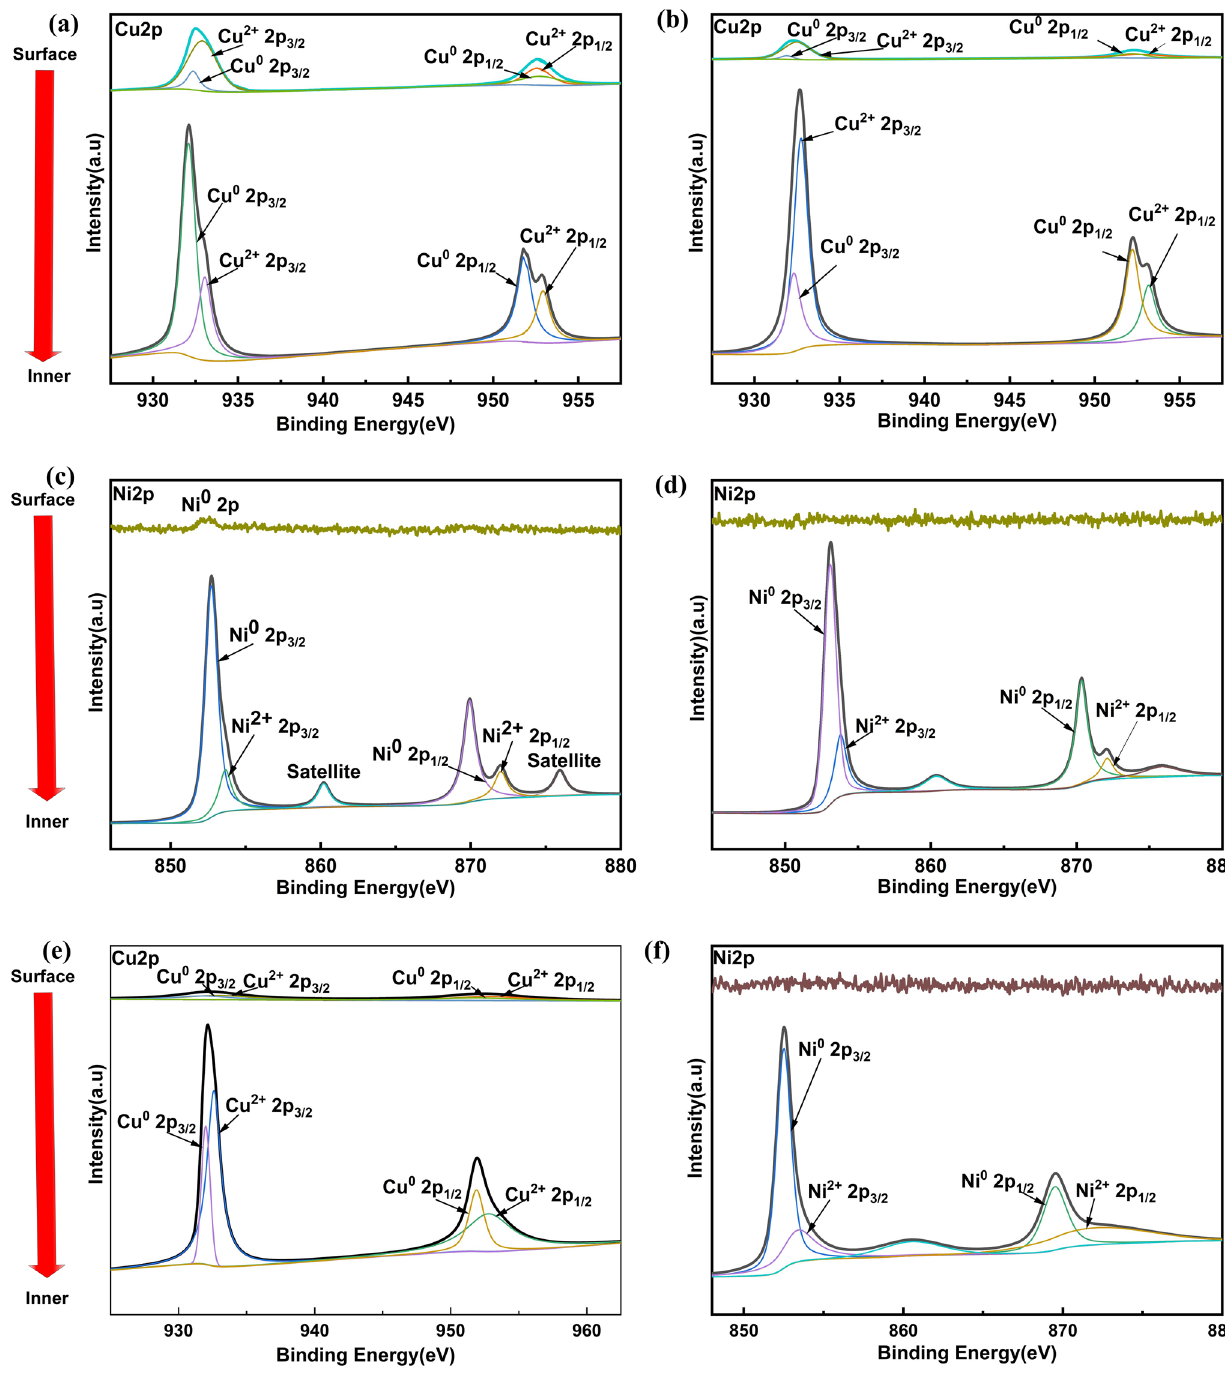
Fig. 8 Comparison of the XPS spectra of the alloying elements distributed on the outermost surfaces (without Ar-ion etching) and underlying surfaces (with Ar-ion etching, 240 s) after immersion in NaCl solution for 2 days. a Cu 2p spectra of the TC sample. b Cu 2p and c Ni 2p spectra of the TCN sample. d Ni 2p spectra of the TN sample. e Cu 2p and f Ni 2p spectra of the Vit1